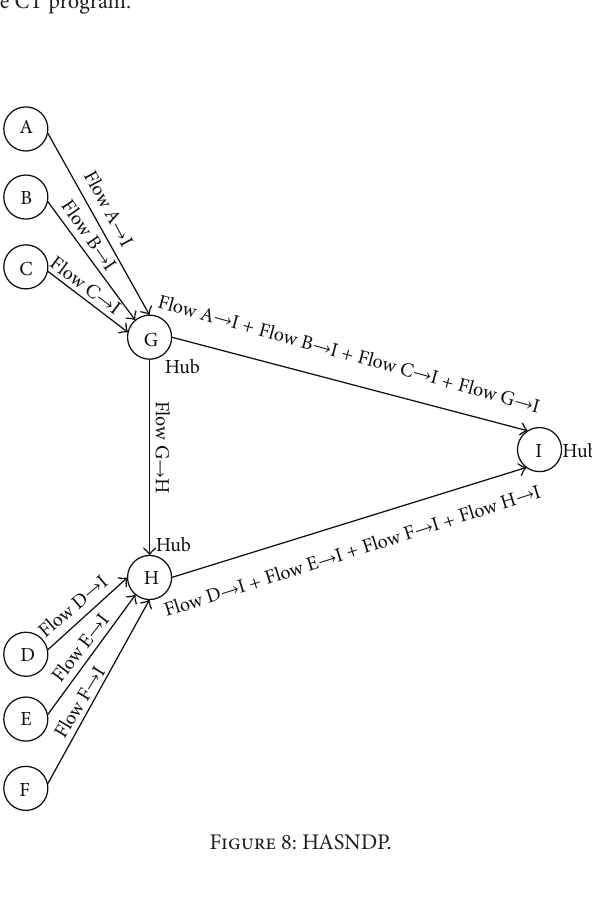
Figure 6: Two-stage CT program.